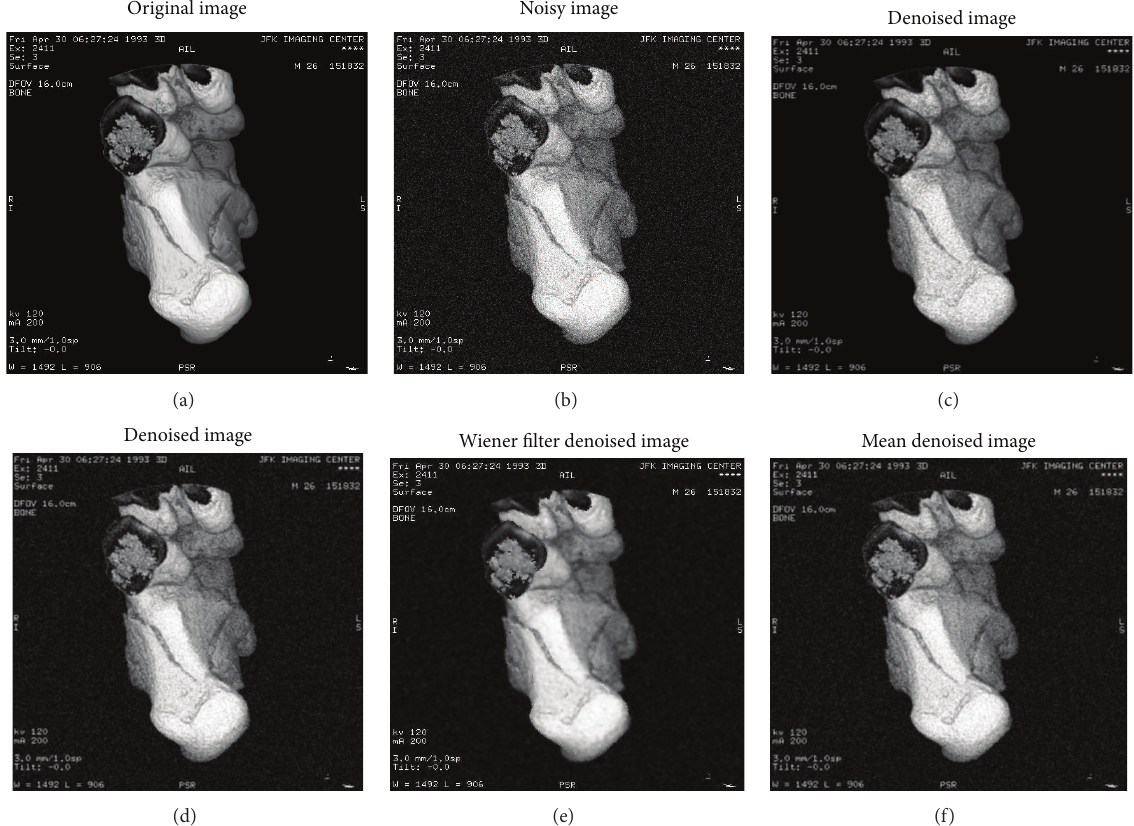
Figure 2: (a) CT image of the ankle bone, (b) CT image with Gaussian noise, (c) denoised image using CSO-FLANN adaptive filter, (d) denoised image using FLANN-LMS adaptive filter, (e) denoised image using Wiener filter, and (f) filtered image using a mean filter (Image Courtesy: CT-MONO2-16-ankle.dcm, MATLAB R2015a).